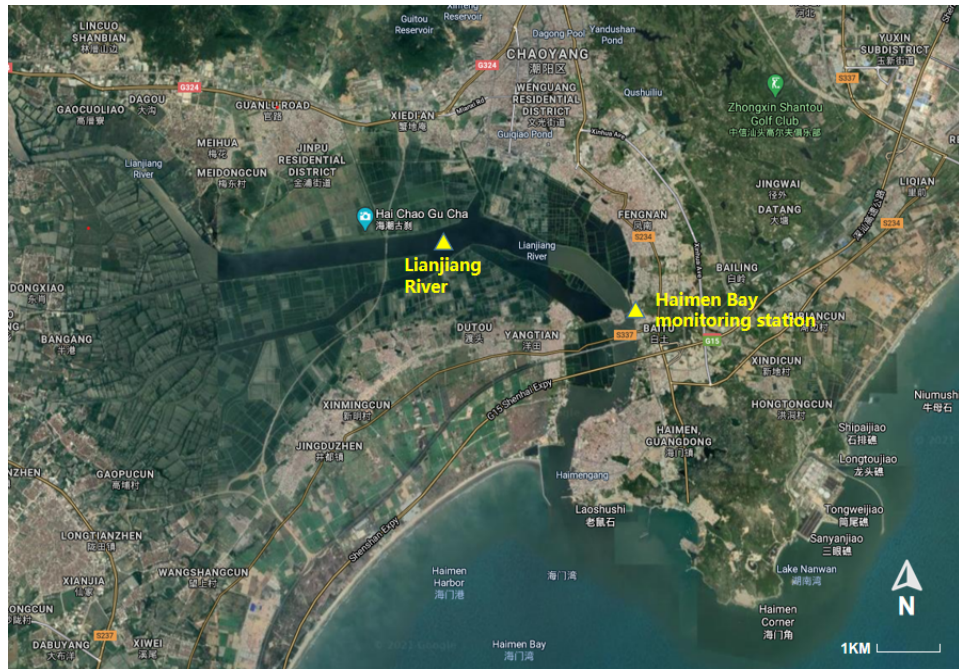
Figure 6. The geographical location of the Haimen Bay Monitoring